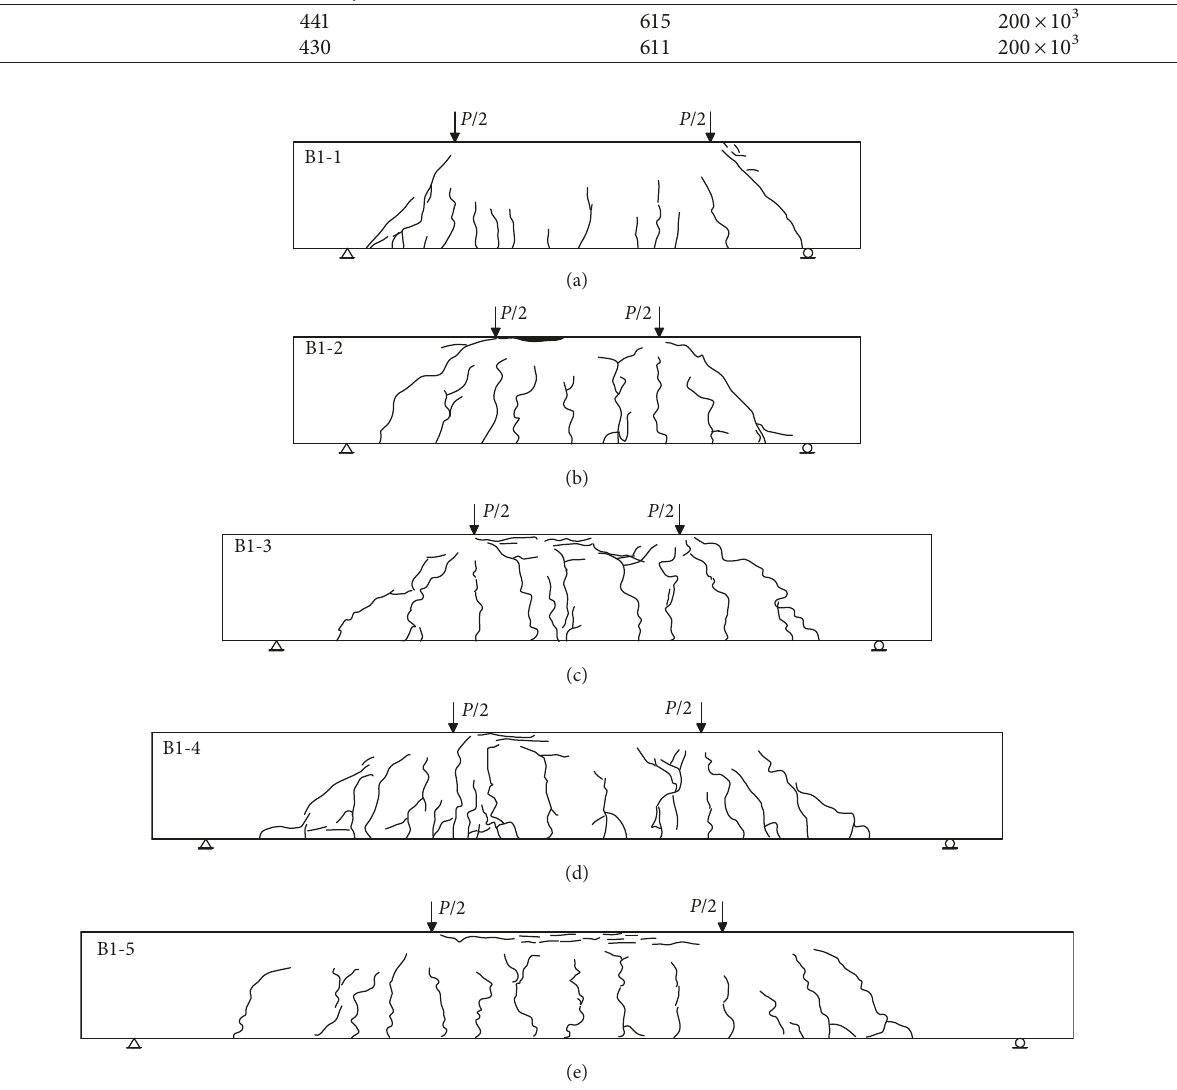
Figure 2: Crack patterns of series B1: (a) B1-1; (b) B1-2; (c) B1-3; (d) B1-4; (e) B1-5.